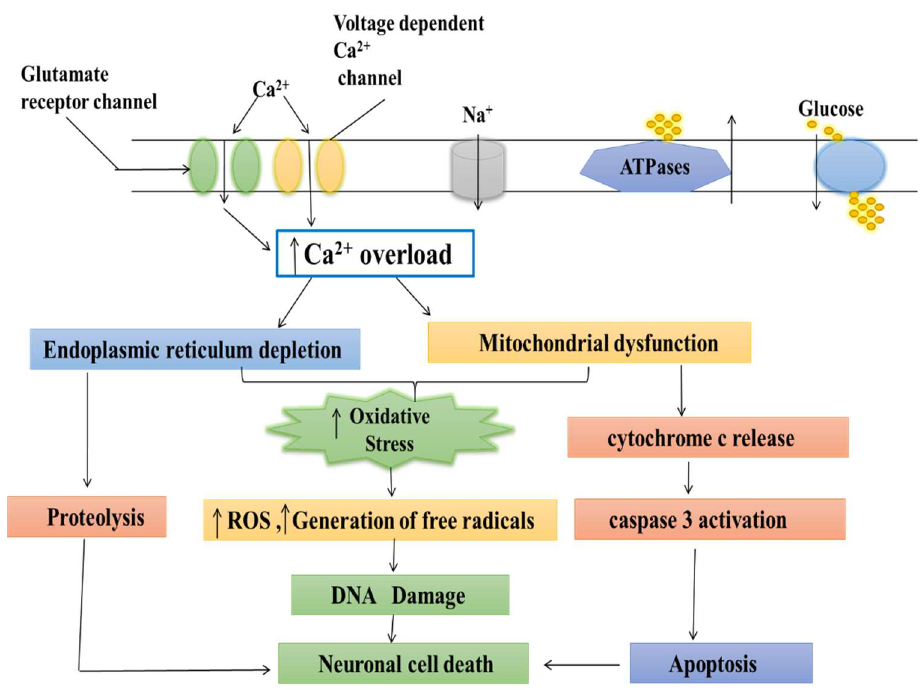
Figure 1. Different mechanisms involved in Parkinson’s disease (mitochondrial dysfunctioning, ox- idative stress (OS), neuroinflammation, gene mutation, and some environmental toxins). These metal toxins aggravate the oxidative stress process in the cell, resulting in cell death by producing an imbalance between free radical and antioxidant enzymes